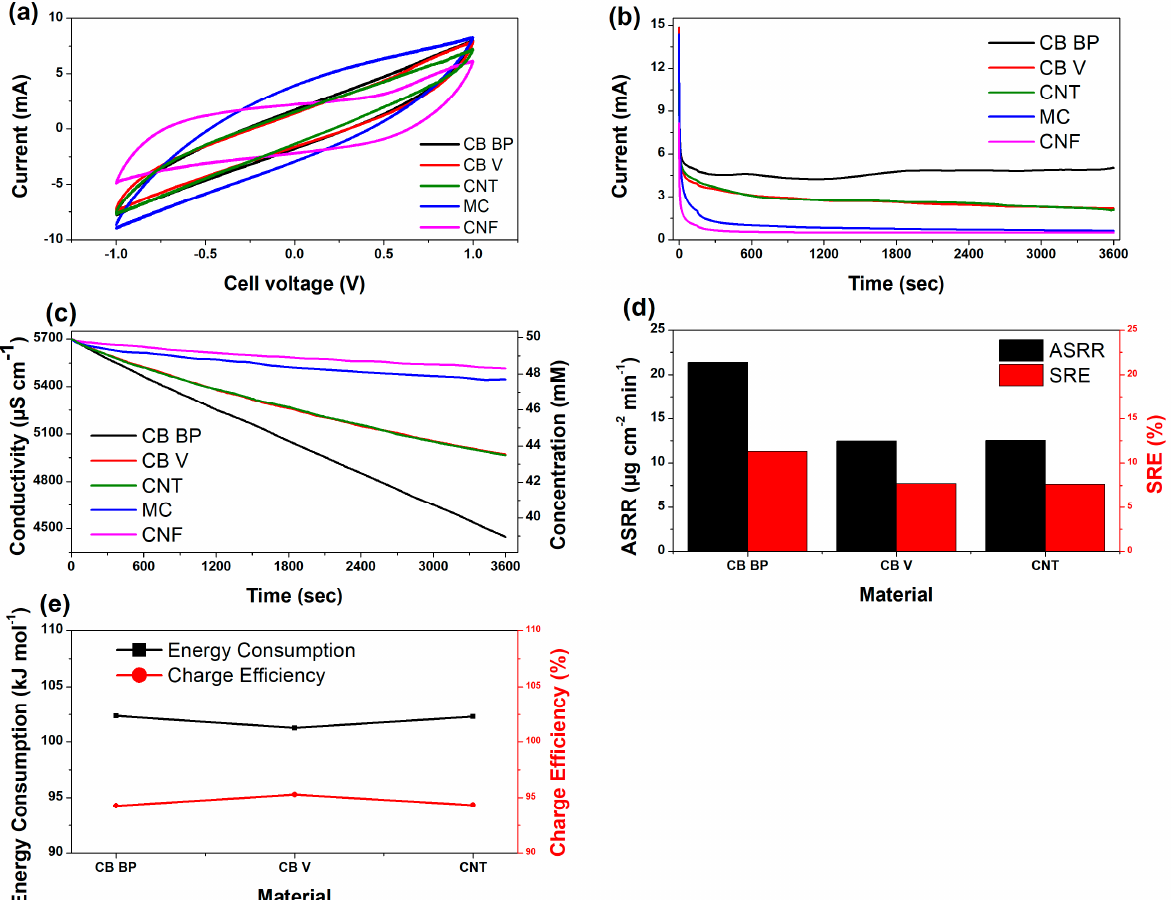
Figure 3. The performance of FCDI cells with different carbon material-based flow electrodes: ( a ) CV curves with a scan rate of 100 mV s − 1 , ( b ) I-t curves with 1 V cell voltage, and the corresponding ( c ) conductivity and saline water concentration changes with time and ( d , e ) determined ASRR, SRE, EC and CE data.